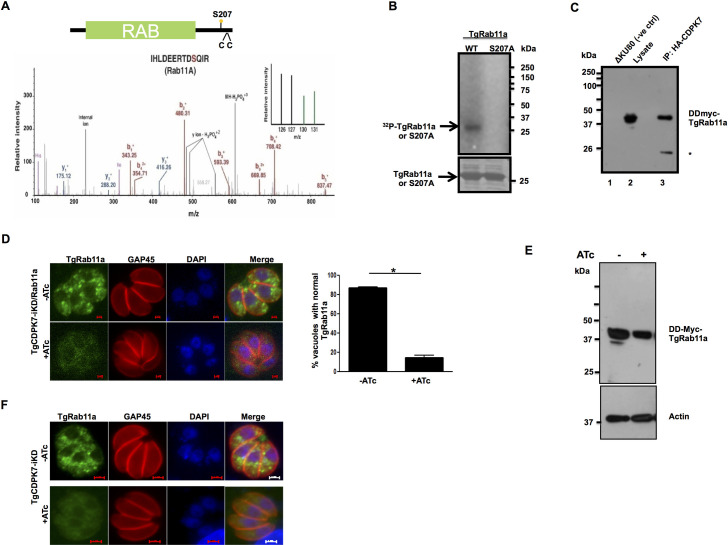
TgCDPK7 phosphorylates TgRab11a and regulates its cellular localization.A. Schematic illustrating TgRab11a domain architecture. The catalytic domain is in green, and the two cysteines (CC) that may be critical for lipid modification like prenylation are indicated. The phosphorylation of S207 was reduced upon TgCDPK7 depletion. MS/MS spectra is provided for the corresponding phosphopeptide. TMT channels highlighted in green in the inset represents independent biological replicates of TgCDPK7 depleted parasites and wild type samples are highlighted in black. B. A deletion mutant of TgCDPK7 (ΔTgCDPK7) that possesses the PH and kinase domain was expressed as a GST tagged protein and was used to phosphorylate recombinant 6xHis-TgRab11a or its S207A mutant in vitro using γ32P-labelled ATP. The reaction mixture was separated by SDS-PAGE and gel was used for phosphorimaging. C. DD-Myc-TgRab11a was ectopically expressed in the presence of Shield-1 in T. gondii parasites in which TgCDPK7 was tagged with HA (TgCDPK7-HA) at the C-terminus. TgCDPK7 was immunoprecipitated using anti-HA antibody. Western blotting was performed on TgCDPK7-IP (lane 3) from these parasites or ΔKu80 (negative control, lane 1) or whole cell lysate (lane 2) using anti-myc antibody. A band corresponding to DD-myc-TgRab11a was observed in TgCDPK7-IP. *, a possible non specific or break down product. D. DD-Myc-TgRab11a was ectopically expressed in T. gondii in TgCDPK7-iKD parasites. Shld-1 was added for 4h to stabilize the expression of TgRab11a and in addition ATc was added for 72h to deplete TgCDPK7. IFA was performed using anti-myc and anti-GAP45 antibodies, which revealed that punctate localization of TgRab11a was lost upon TgCDPK7 depletion. Right Panel, Quantification of vacuoles containing normal punctate TgRab11a staining, from experiments described in the left panel. Data are mean ± SE of three independent experiments and at least 200 vacuoles were counted for each condition (*, n = 3, p<0.001, t-test). E. DD-Myc-TgRab11a was ectopically expressed in T. gondii in TgCDPK7-iKD-HA parasites, ATc treatment was given for 72h and parasites were incubated with Shld-1 for 4h. Western blotting was performed using anti-myc antibody or anti-actin, which was used as loading control. F. IFA was performed using anti-TgRab11a antibody on untreated or ATC-treated TgCDPK7-iKD parasites. ATc treatment resulted in loss of punctate TgRab11a localization and was diffuse.